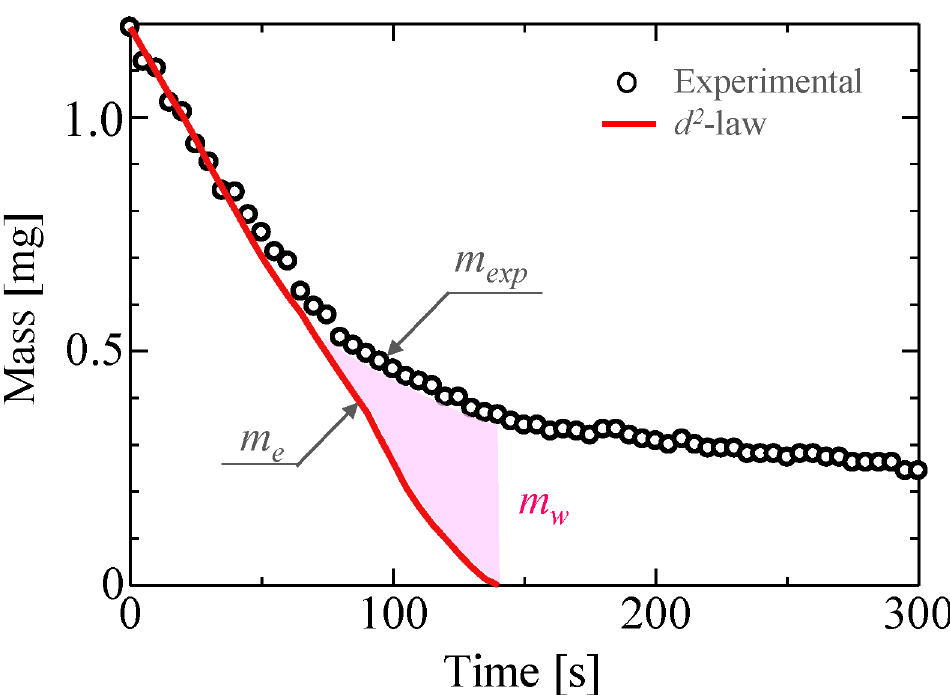
Fig 10. Conceptual diagram of mass estimation of ethanol